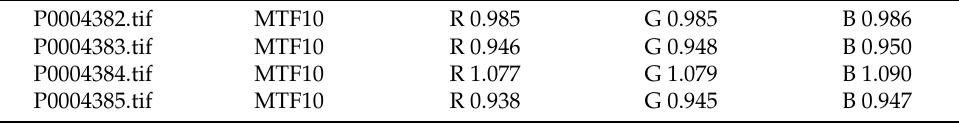
Table 4. Results of spatial resolution